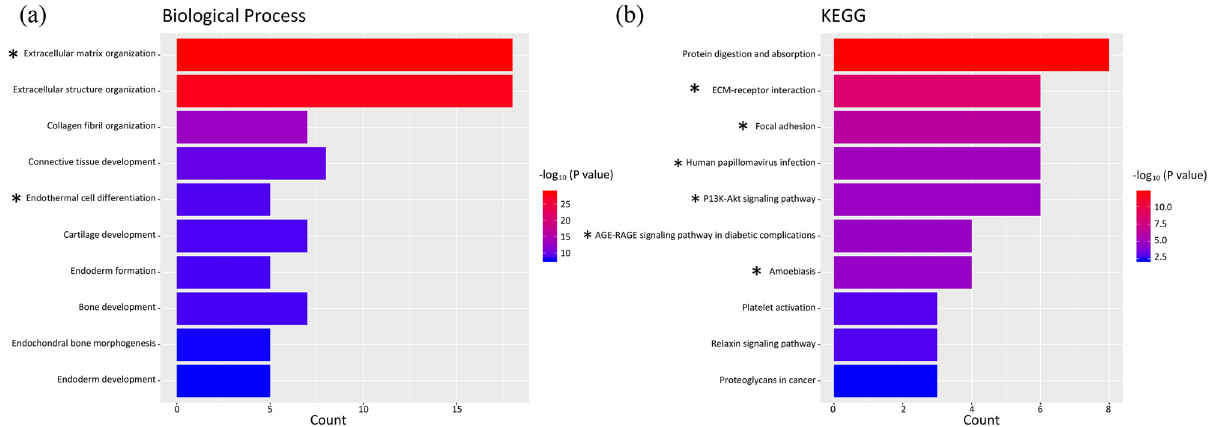
Figure 2: GO term and KEGG pathway enrichment analyses of the DEGs. ( a ) Biological process ( BP ) term enrichment analysis for the DEGs. ( b ) KEGG pathway enrichment analysis for the DEGs. GO, Gene Ontology; KEGG, Kyoto Encyclopedia of Genes and Genomes. An asterisk “ * ” denotes FN1 - related